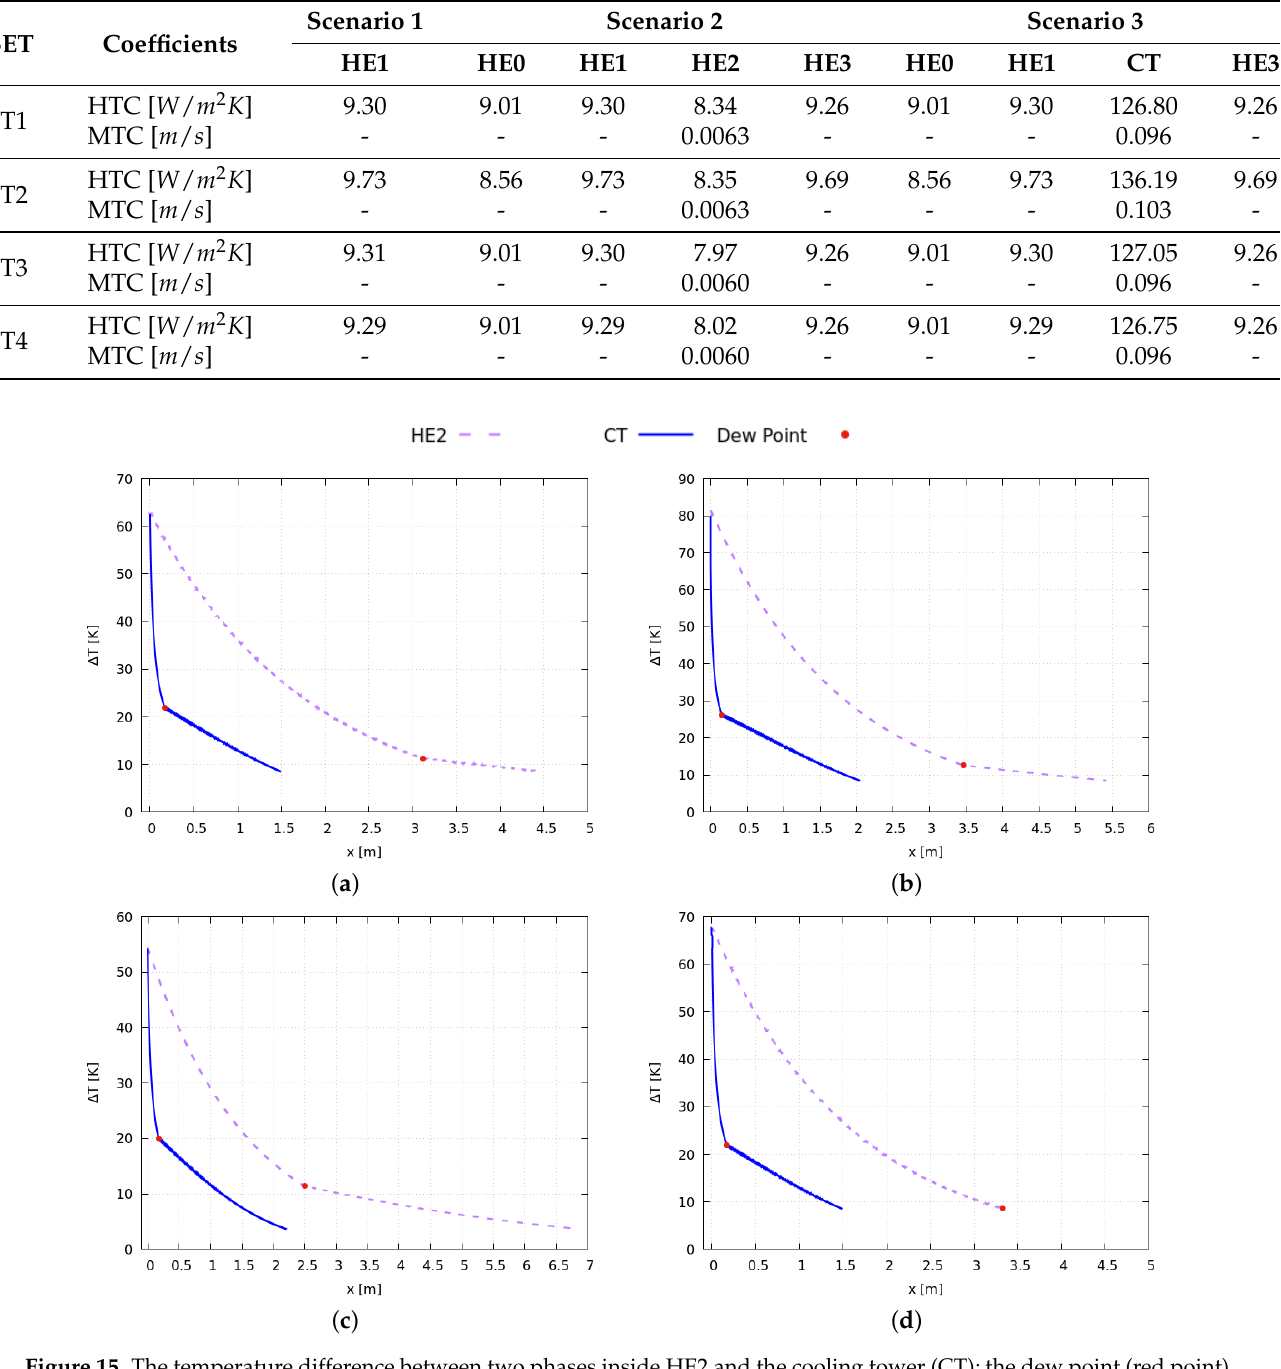
Figure 15. The temperature difference between two phases inside HE2 and the cooling tower (CT); the dew point (red point) separates the saturation from the condensation step: SET1 ( a ), SET2 ( b ), SET3 ( c ), and SET4 ( d